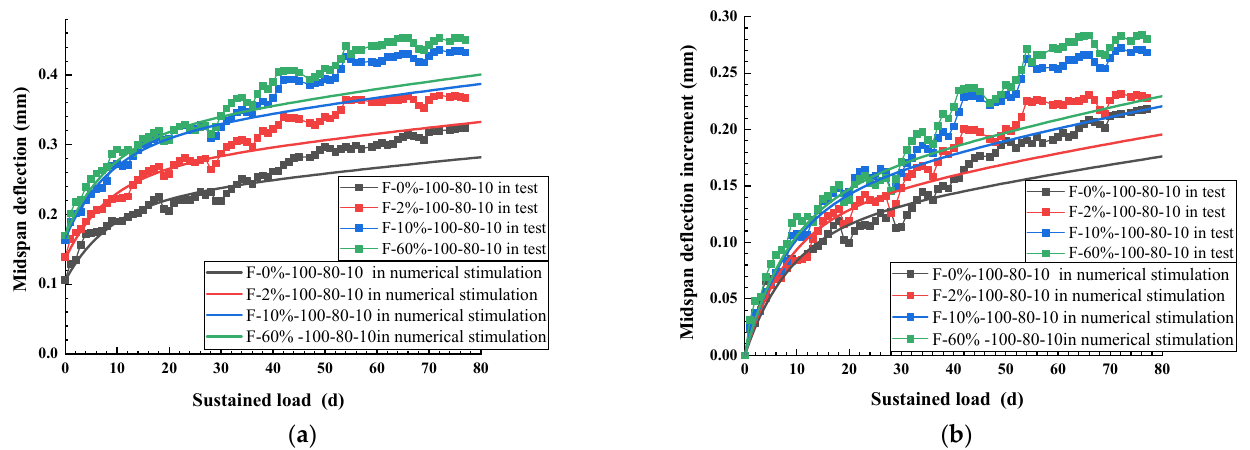
Figure 12 delineates the numerical and experimental midspan de fl ection and midspan de fl ection increment of the components.